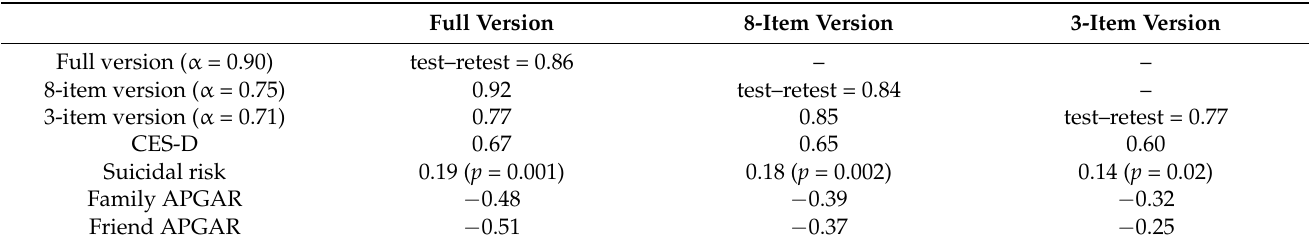
Table 4. Concurrent validity, test–retest reliability, and internal consistency of the three versions of the UCLA Loneliness Scale, Version 3 ( n =